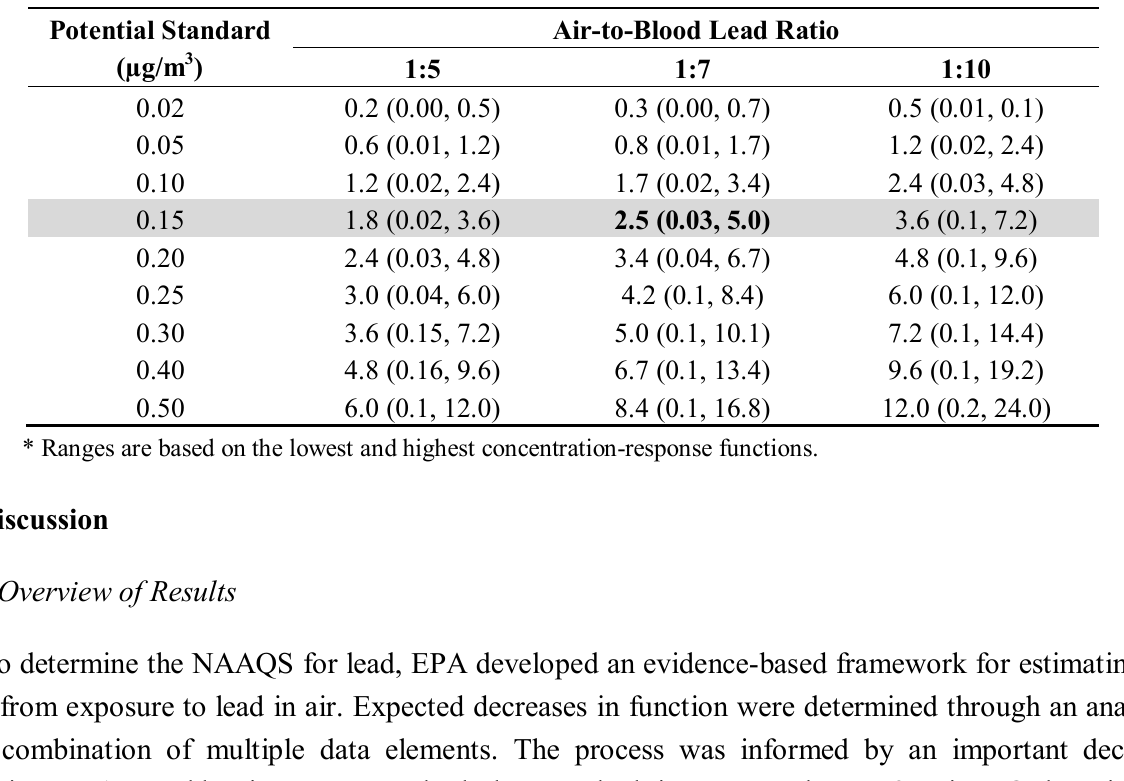
Table 4. Expected mean intelligence loss estimates for children at different air lead standard levels using concentration-response functions developed in low socioeconomic groups